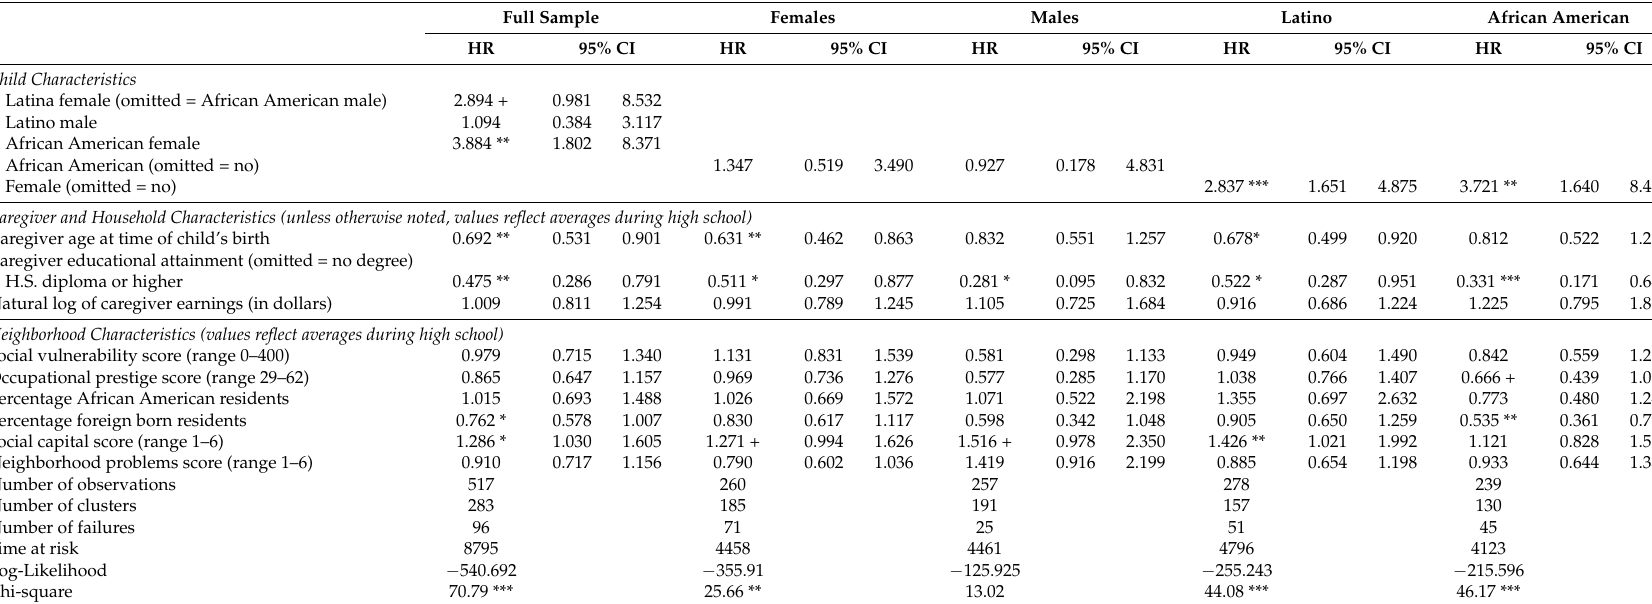
Table 3. Standardized Cox PH Models Predicting Hazards of Giving Birth or Fathering a Child between ages 15 and 19 Years, Instrumental Variable Models. Full Sample Females Males Latino African American HR 95%